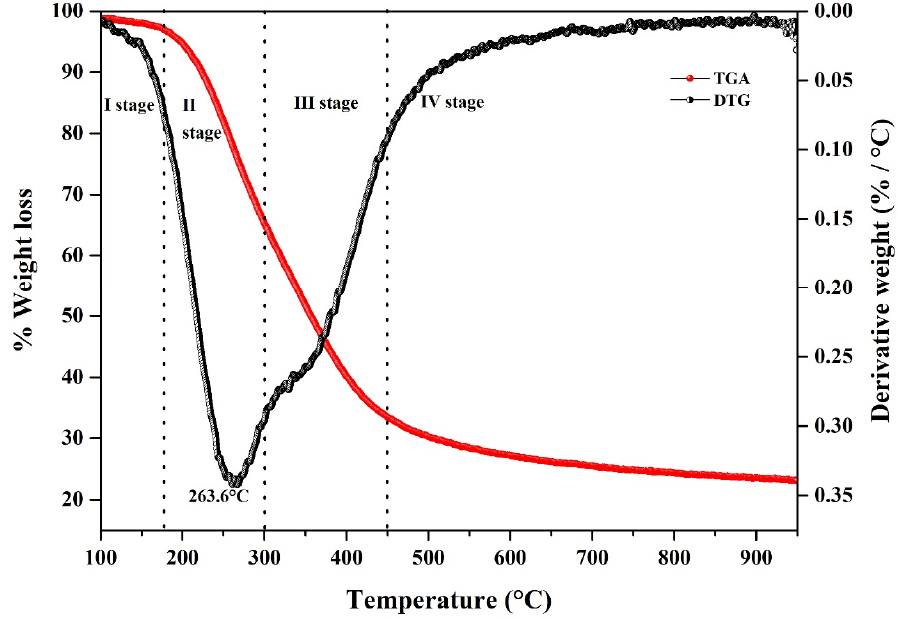
Figure 5. Thermogravimetric analysis (TGA and DTG) of [N11H(2OH)][LAC]-extracted lignin from pine wood biomass. The degradation of the [N11H(2OH)][LAC]-extracted lignin was divided into three stages. In the first stage, the initial weight loss observed at 120.6 °C is due to the evapora- tion of absorbed moisture [31]. The second degradation occurs between 180–450 °C, and is predominantly due to the cleavage of interunit linkages to volatile substances such as CO, CO 2, and CH 4 [32]. The last phase is related to char combustion, and includes the decomposition of aromatic rings in methoxylation reaction of hydroxyl and volatile com- pounds from lignin [33]. From DTG, enhanced lignin decomposition occurs between the temperature range of 220 °C and 500 °C, and the maximum lignin degradation (DTG max ) occurs at 263 °C, which is significantly lower than the commercial Kraft lignin (355 °C) [31]. The relatively lower thermostability is due to the higher fragmentation of lignin dur- ing [N11H(2OH)][LAC] extraction and the presence of weak linkages, which is concomi- tant with the earlier reports [33,34]. Further, the formation of highly condensed aromatic structures at elevated temperatures yielded a residual carbon content of 23% [29]. 3.3.3. Molecular Weight Distribution of [N11H(2OH)][LAC]-Extracted Lignin The development of a high-value product from lignin is significantly influenced by the molecular weight and the polydispersity index (PDI) properties. Therefore, tuning these properties improves the application of lignin in various fields [35]. Thus, the molec- ular weight distribution of [N11H(2OH)][LAC]-extracted lignin from PWB, along with that of commercial alkali Kraft lignin, is presented in Table 1 and Figure 6.